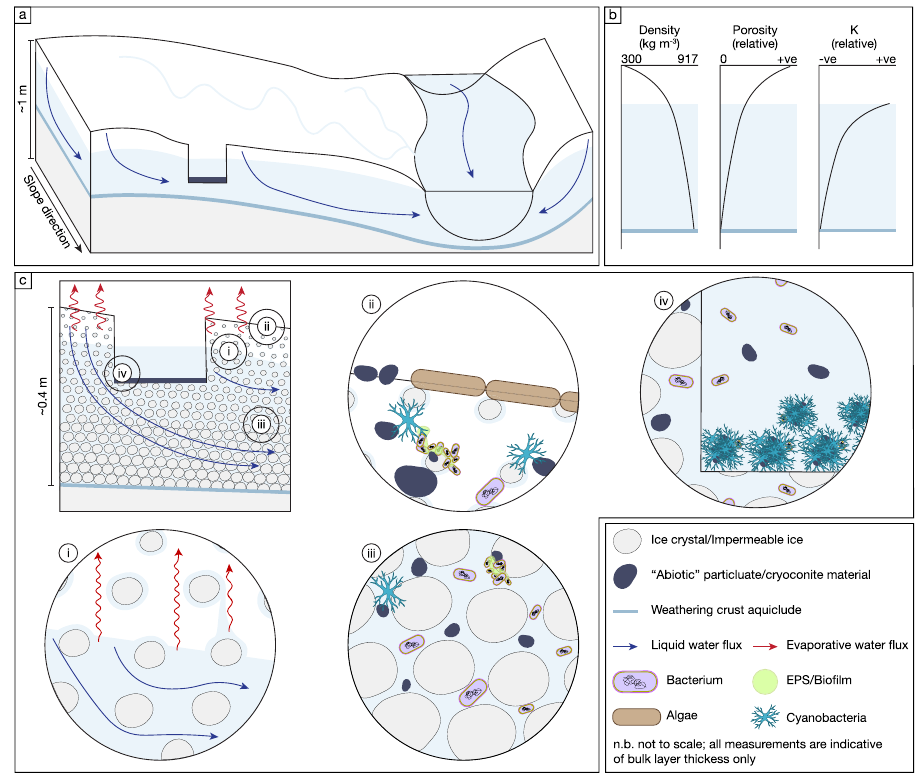
Fig. 1 A conceptual model of the glacial weathering crust. a A catchment-scale transect and water fl ow across and beneath the ice surface, for which b indicative depth-variable relationships for bulk ice density, porosity and hydraulic conductivity ( K ) are shown. c Insets depict exemplar meltwater- saturated or unsaturated microbial habitats or niches: i) shows the near-surface unsaturated zone with capillary draw and evaporative water fl uxes; ii) illustrates the highly porous ice-atmosphere interface where glacier ice algae thrive; iii) portrays the saturated weathering crust zone; and iv) represents a cryoconite hole ecosystem that punctuates the weathering crust, hosting a one-particle thick layer of cryoconite granules. Microbes suspected to be present in each environmental niche are